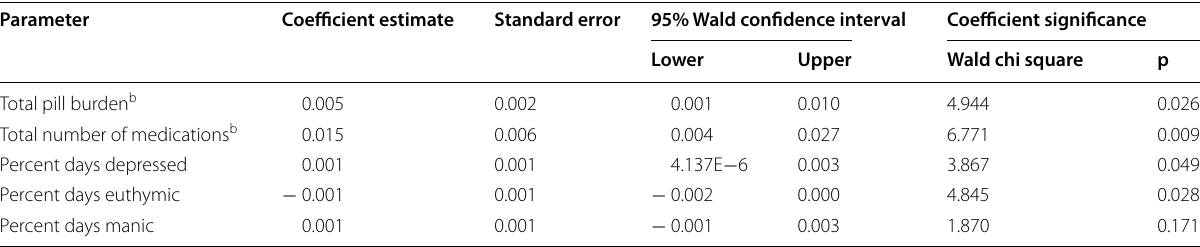
Table 3 Estimated coefficients of parameters associated with daily dosage irregularity for mood stabilizers and second generation antipsychotics